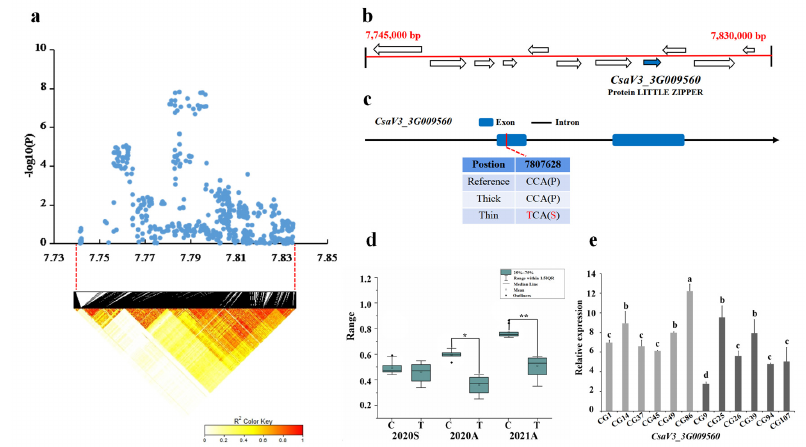
Figure 6. Identification of the stem diameter-related gene at locus gSD3.1 . ( a ) Manhattan map of near 100 kb ( top ) and LD heatmap ( bottom ) surrounding the peak of gSD3.1 . ( b ) Eleven genes predicted in the LD block region. Blue represents the genes that are different. ( c ) SNP variation of the candidate gene CsaV3_3G009560 among thick and thin stem lines (Table S6). One SNP (in red) was located